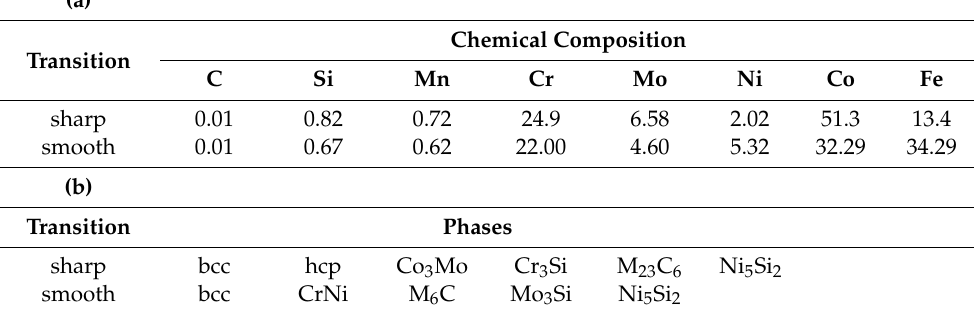
Table 2. ( a ) Chemical composition of the transition zones of MMAM samples of AISI316L and CoCrMo determined by OES, in wt.%. ( b ) Computational phase composition based on equilibrium calculations in ThermoCalc